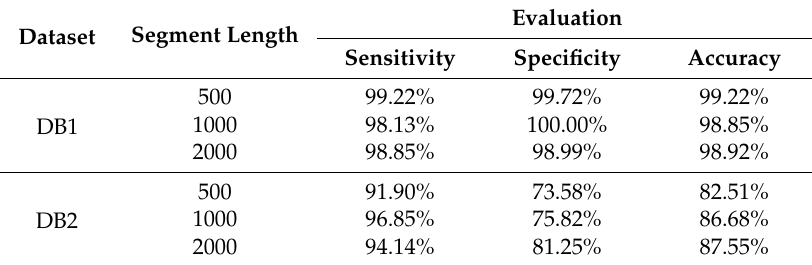
Table 8. Results of blindfold